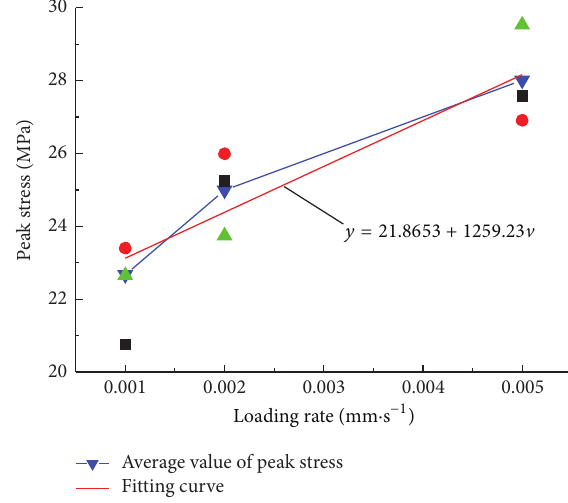
Figure 4: The relationship between peak stress and loading